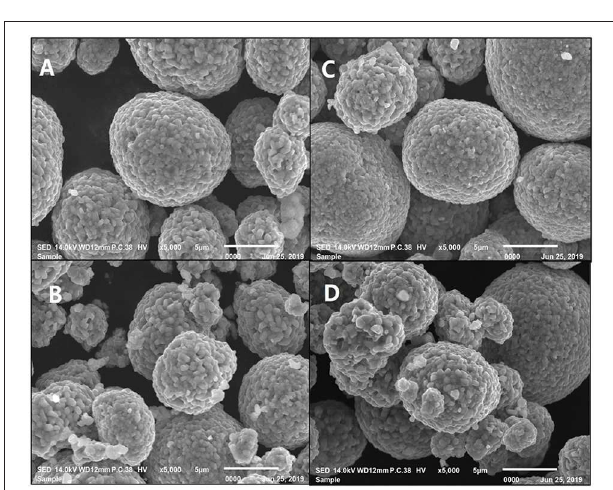
FIGURE 3 | SEM of NCM811 samples ( A -uncoated, B -Coated by Al 2 O 3 , C -Coated by ZrO 2 , D -Coated by LBO).